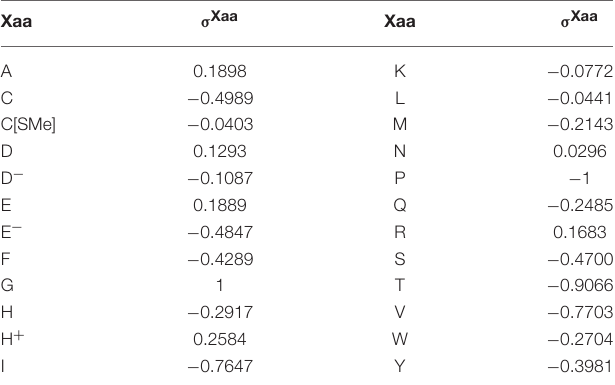
a Each tensor σ (C α ) is the average of the values obtained with two models of secondary structure, a hairpin (AcGGGGGXaaNHMe/Ib) and a helix (AcGXaaGGGNH 2 /3 10 ), at the GIAO//B3LYP/D95 ** level of the theory. The mean values for the trans and –gauche conformers of the side chain about the C α -C β bond are taken when appropriate (Kyte, 1995). b The σ Xaa constantsforsomecovalentlymodifiedaminoacidsare:SerO γ -PO -2 Ser O γ -PO -1 3 approx. − 0.6160, Met S( = O) 2 − 0.1101, Lys N ξ -COCH 3 − 0.2518, Val C β -CH 3 − 0.9993, Ala C β -F 3 − 0.4258, Phe -F 5 − 0.0829, Leu C δ -F 3 /C δ -F 3 0.0049,